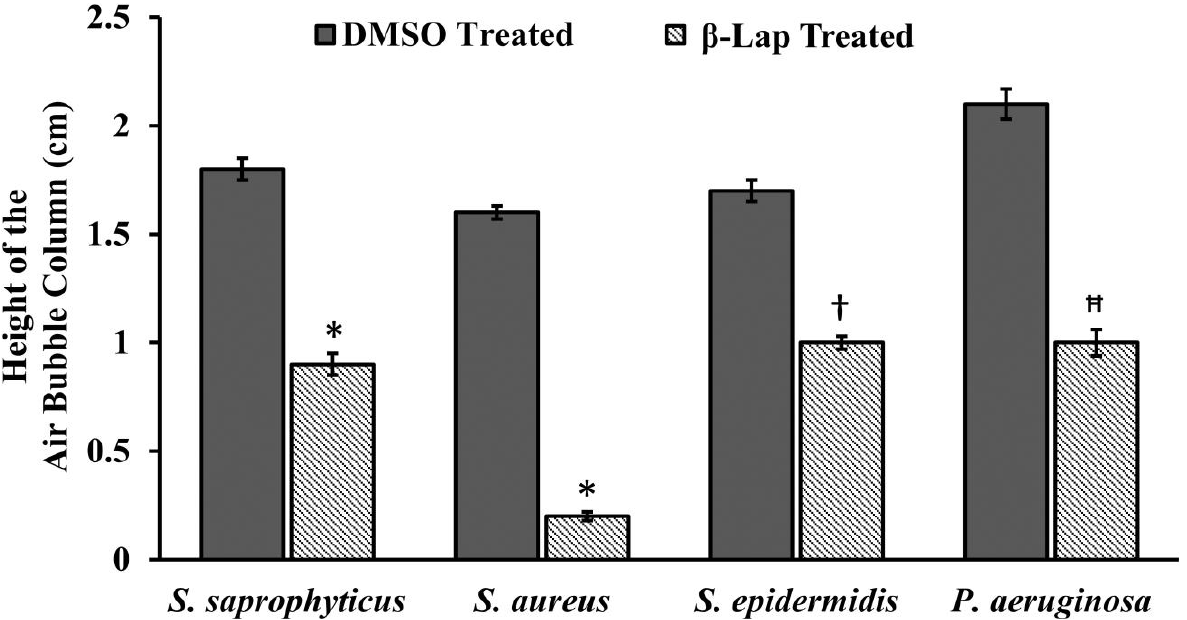
Figure 4 . Catalase inhibition in β -Lap treated cells: The cells of the bacterial strains individually treated with DMSO (gray columns) and β -Lap (striated columns) were assayed for catalase production by measuring the height of air bubble column after the addition of H 2 O 2 . *; p < 0.002, †; p < 0.004, ꟸ ; p < 0.007. Figure 4 . Catalase inhibition in β-Lap treated cells: The cells of the bacterial strains individually treated Figure 4 . Catalase inhibition in β-Lap treated cells: The cells of the bacterial strains individually treated with DMSO (gray columns) and β-Lap (striated columns) were assayed for catalase production by Figure 4. Catalase inhibition in β -Lap treated cells : The cells of the bacterial strains individually treated with DMSO (gray columns) and β-Lap (striated columns) were assayed for catalase production by measuring the height of air bubble column after the addition of H 2 O 2 . *; p  0.002, †; p  0.004, ꟸ ; p  with DMSO (gray columns) and β -Lap (striated columns) were assayed for catalase production by measuring the height of air bubble column after the addition of H 2 O 2 . *; p  0.002, †; p  0.004, ꟸ ; p  0.007. measuring the height of air bubble column after the addition of H 2 O 2 . *: p < 0.002, †: p < 0.004, Figure 3 . β -Lap treated cells are sensitive to H 2 O 2 : Bacterial cultures individually treated with DMSO 0.007. and β -Lap were subjected to H 2 O 2 stress. The CFUs enumerated post-H 2 O 2 stress were plo tt ed. *; p : p < < 0.002, †; p < 0.004, ꟸ ; p < 0.007.